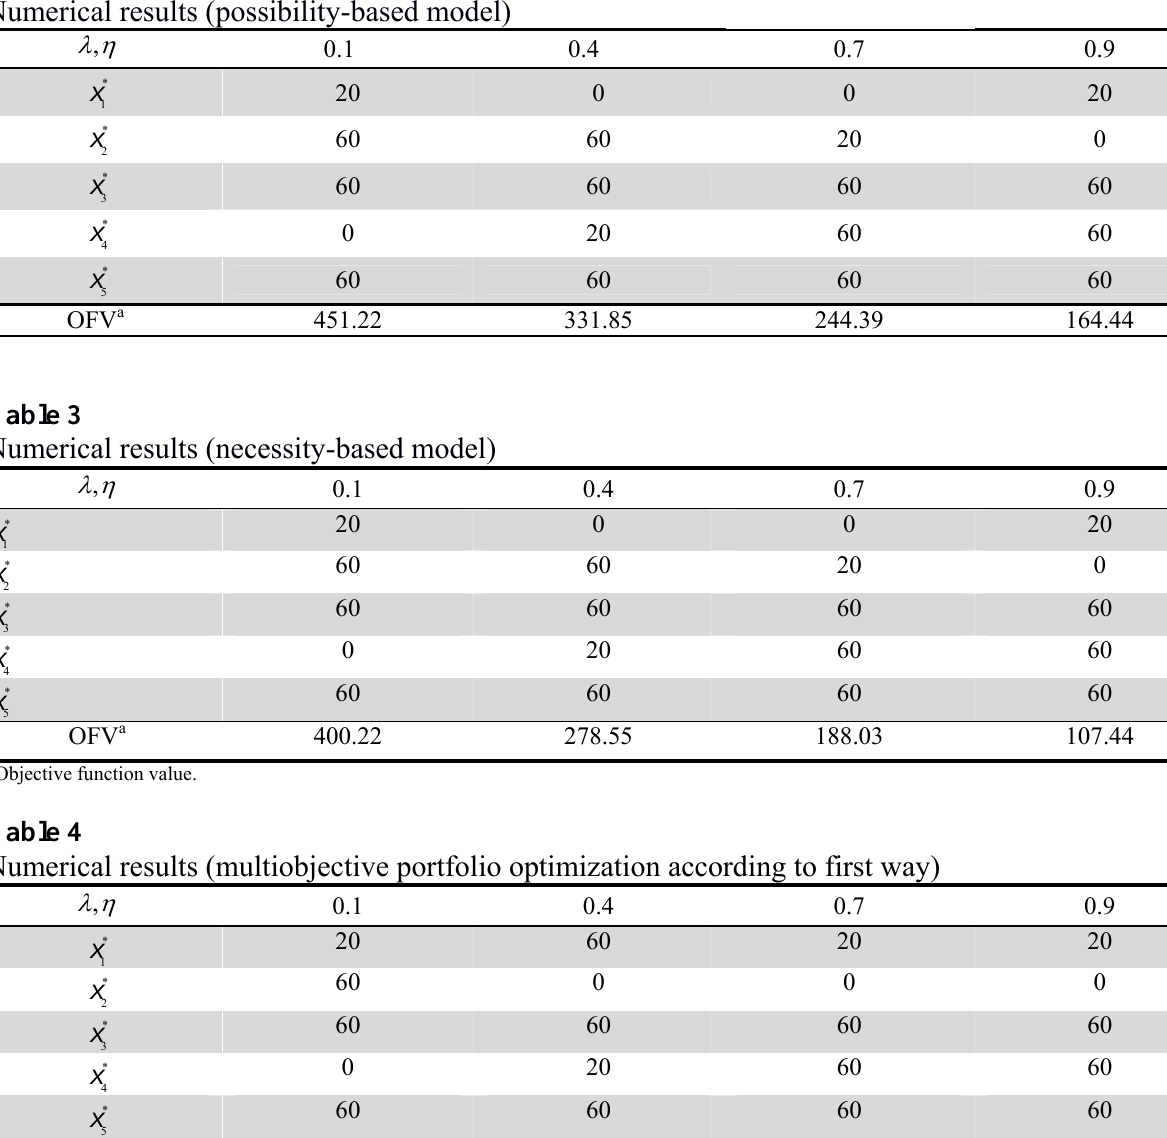
OFV b P OFV b N b Objective function value of Possibility and Necessity-based model Numerical results (multiobjective portfolio optimization according to second way)